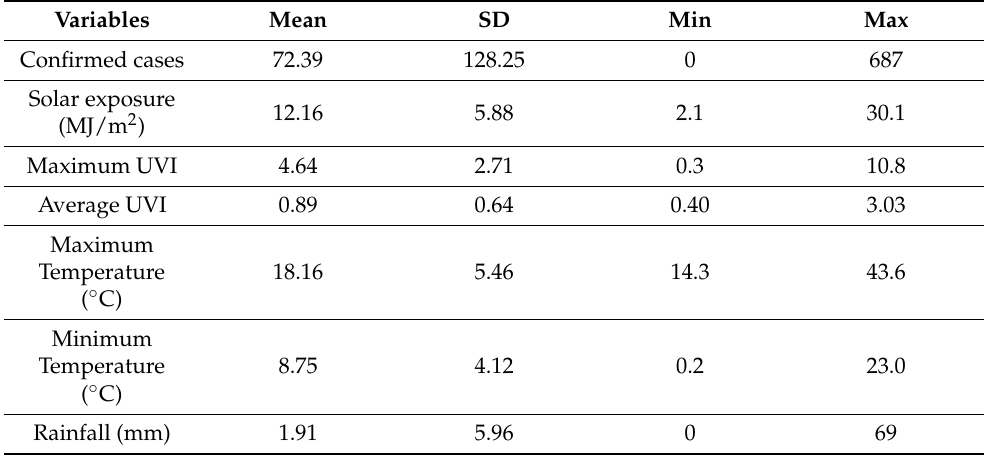
Table 1. Descriptive statistics of the daily confirmed cases and six meteorological variables for